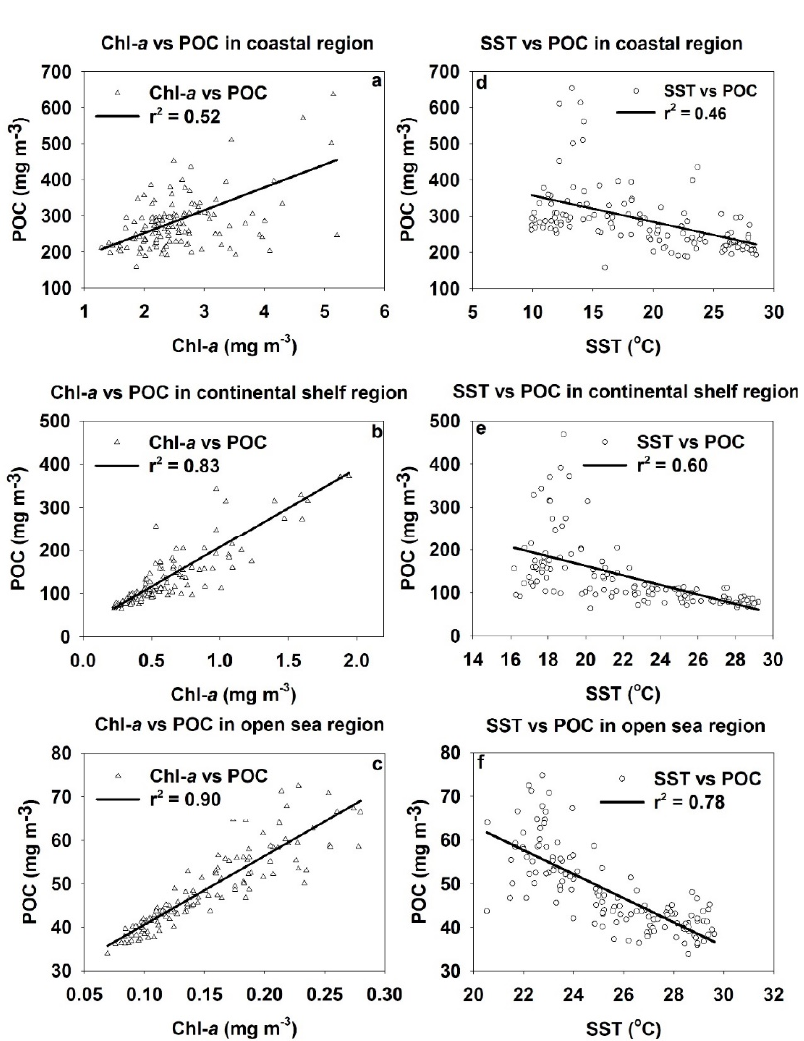
Figure 4. Plots a–c represent the monthly averaged Chl- a vs. POC in all three selected regions of the ECS; Plots d–f represent the monthly averaged SST vs. POC. The r 2 value represents the correlation coefficient and all data comparisons have passed the significance test ( p < 0.05).